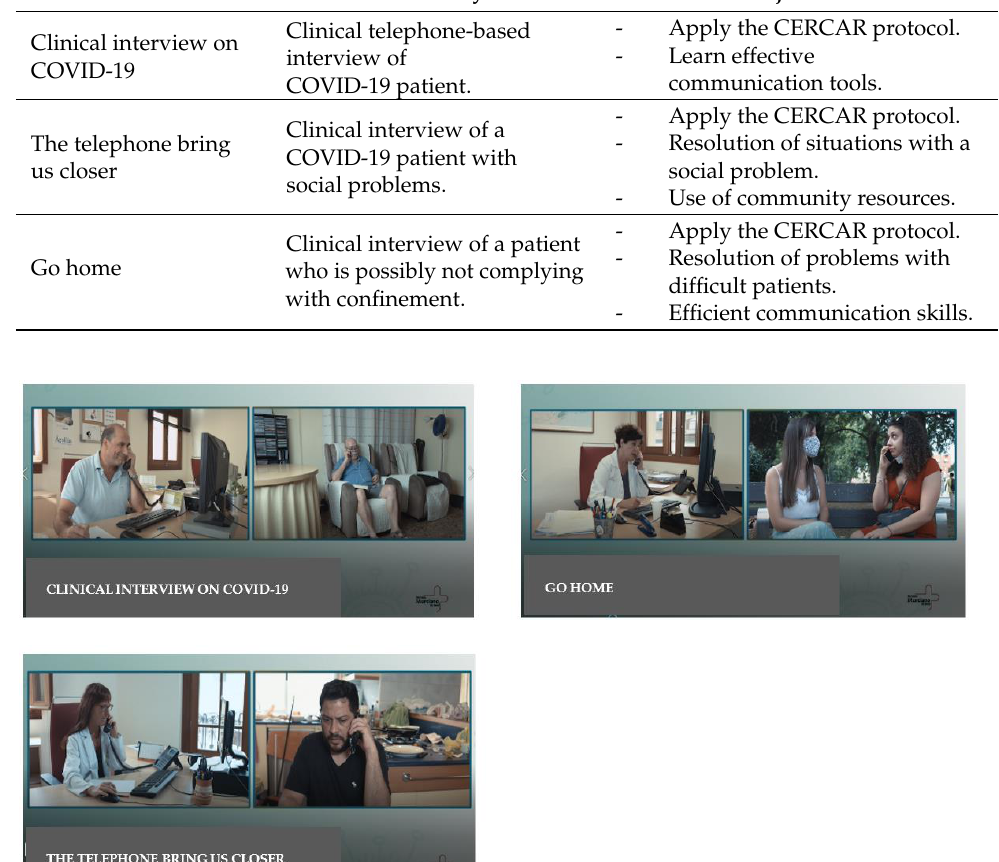
Figure 1. Teaching/problem videos of clinical cases with COVID-19 patients.